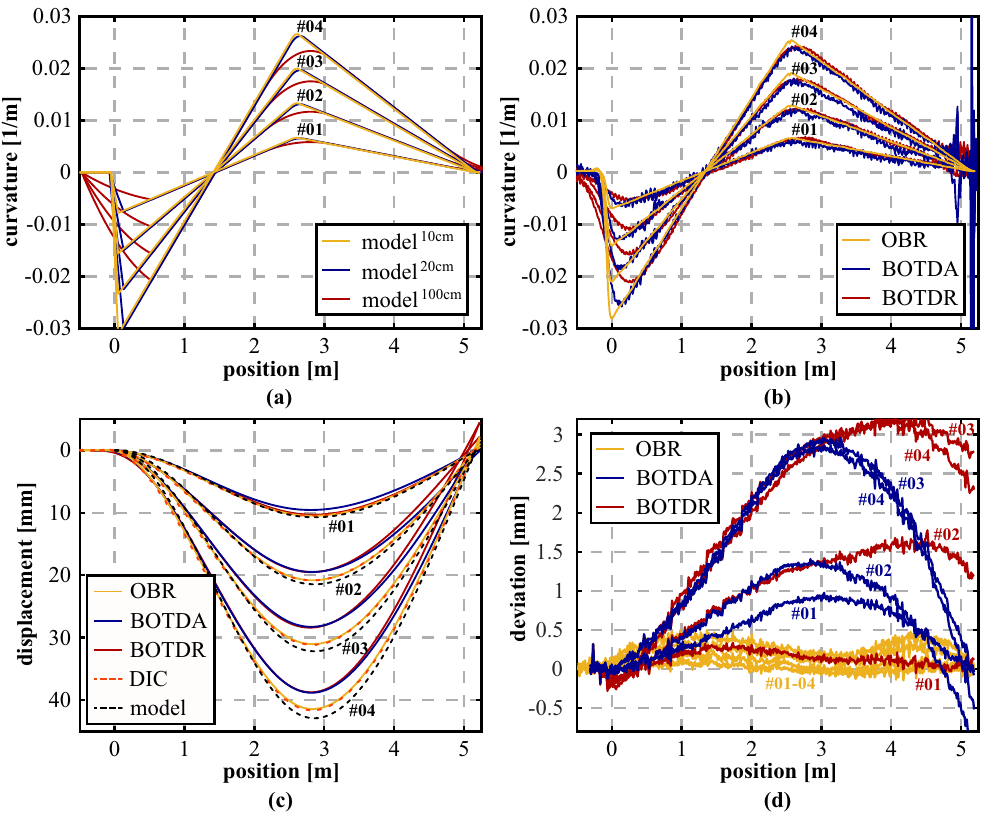
Figure 8. Laboratory testing results: ( a ) Theoretical curvature distribution. ( b ) Curvature profiles derived from DFOS strain measurements. ( c ) Displacement curves calculated from DFOS strains, DIC, and theoretical model. ( d ) Deviations between DFOS and